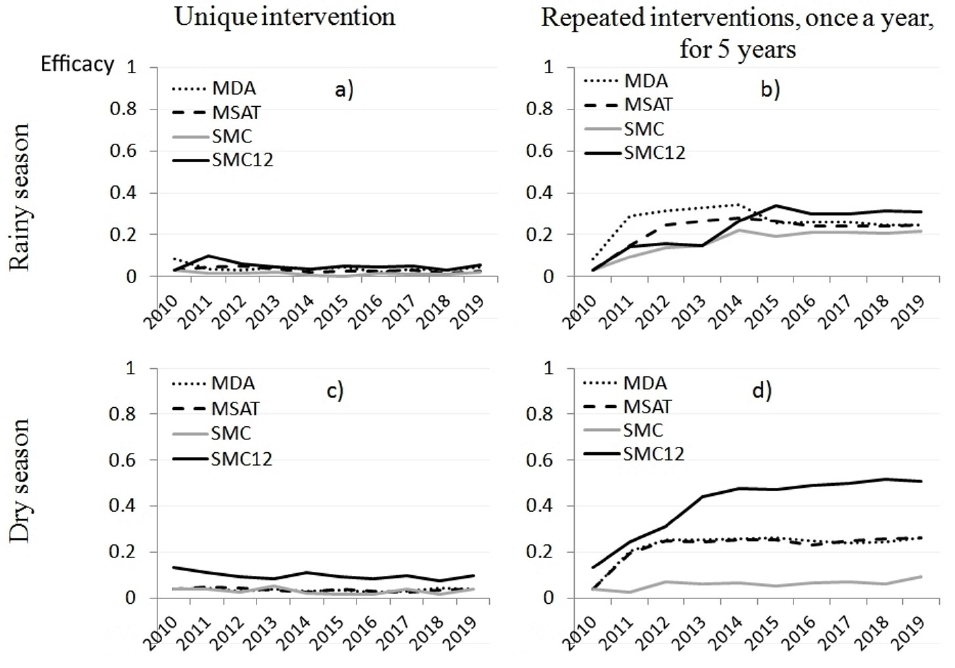
Figure 4. Decrease in malaria incidence while targeting low transmission (LT) hotspots in Mbour, Senegal, 2008–2012. The y-axis represents the relative decrease in malaria incidence for the overall area (45 villages). ( a ) unique one-year intervention in the rainy season, ( b ) repeated interventions over five consecutive rainy seasons, once per year, ( c ) unique one-year intervention in the dry season, ( d ) repeated interventions over five consecutive dry seasons, once per year. SMC12 corresponds to a theoretical schedule of uninterrupted monthly administration of SMC over 12